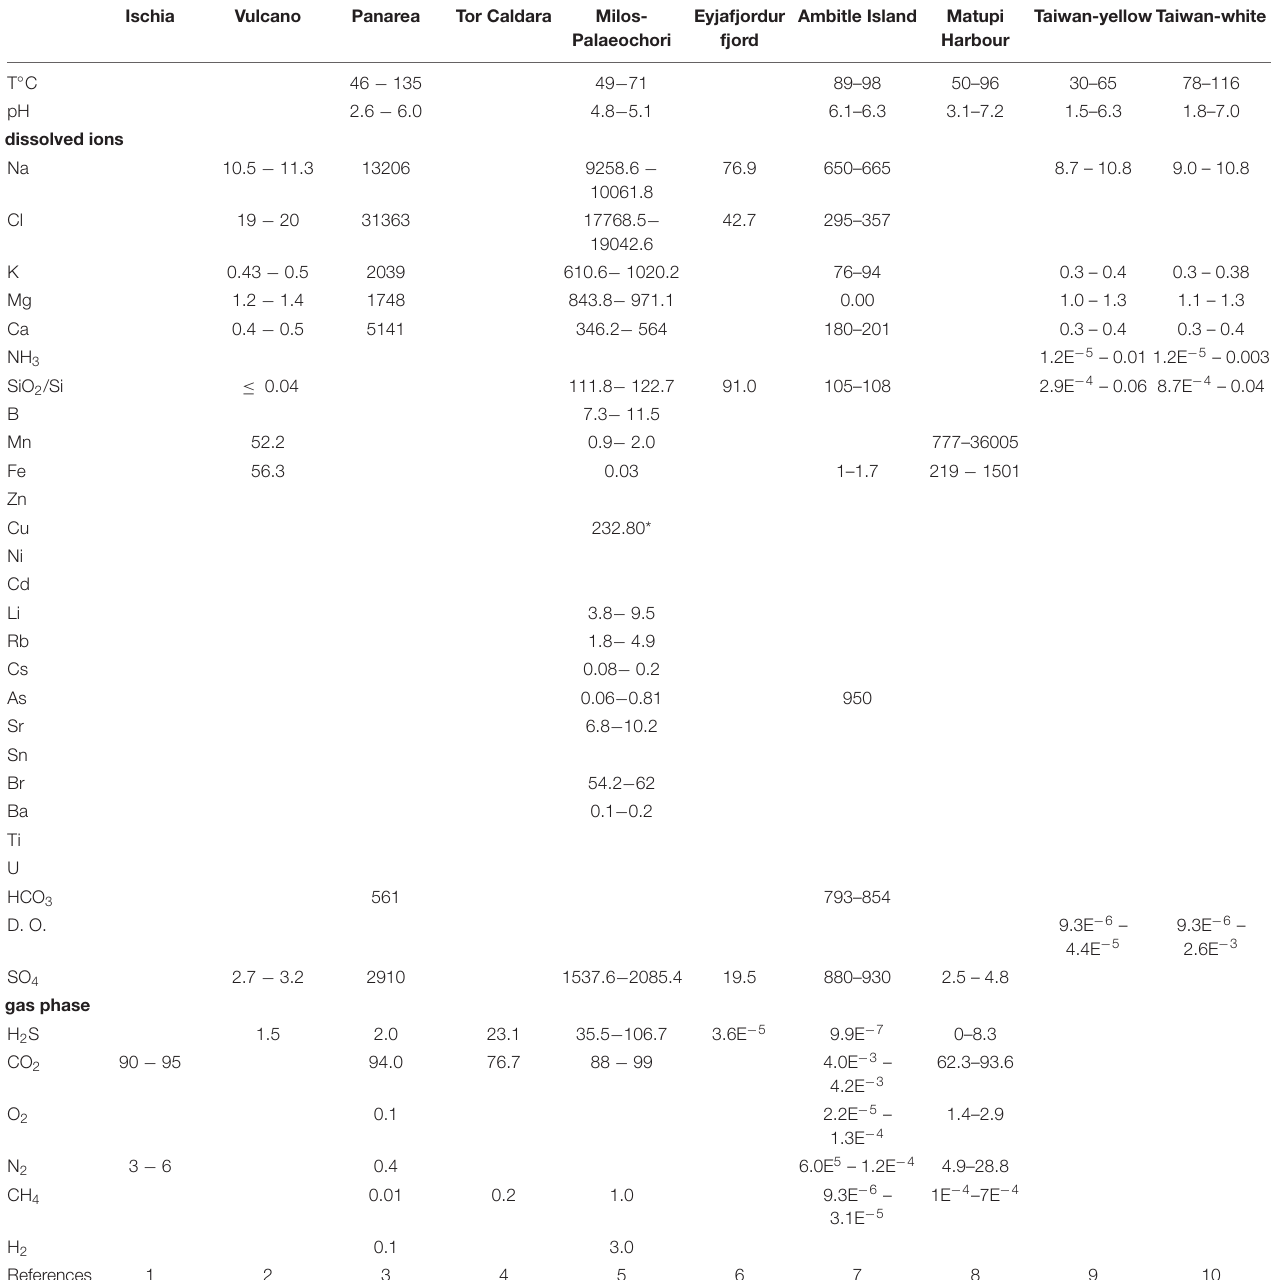
TABLE 1a | Main physical parameters and chemical composition of the emitted fluids (in ppm, Ba in ppb) and gases (in%) from Ischia, Volcano, Panarea, Tor Caldara, Milos, Eyjafjordur, Ambitle. Matupi, and Taiwan. Ischia Vulcano Panarea Tor Caldara Milos-